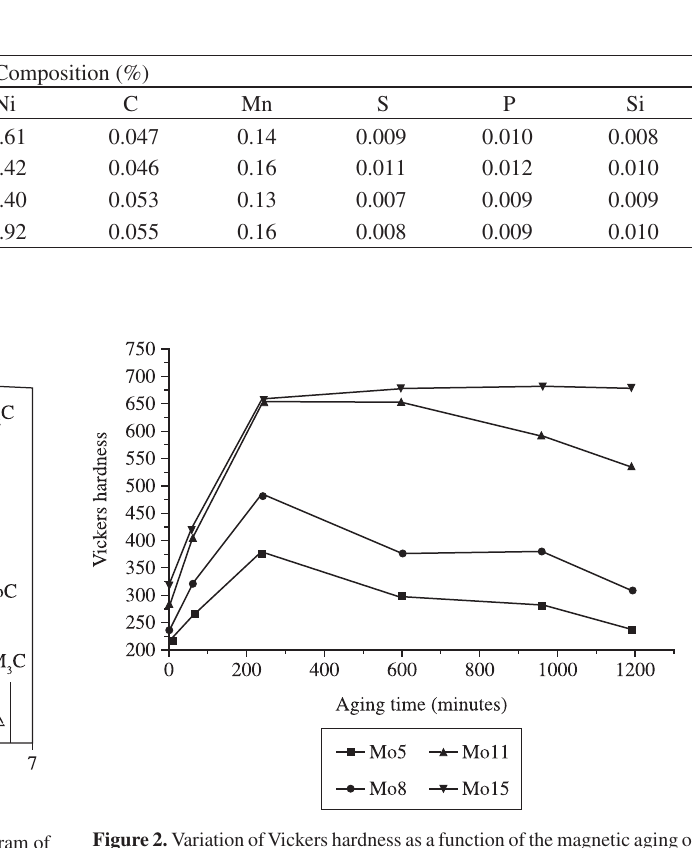
Figure 1. Isothermal section at 700 °C for the phase equilibrium diagram of Fe-Mo-C system.